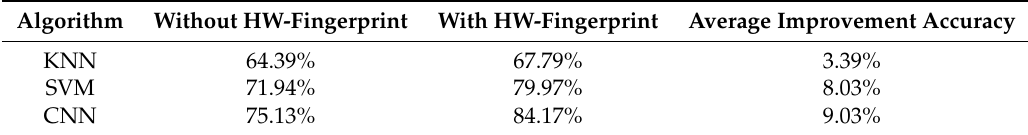
Figure 11. The results of experiment with and without HW-fingerprint. Table 5. Average daily location